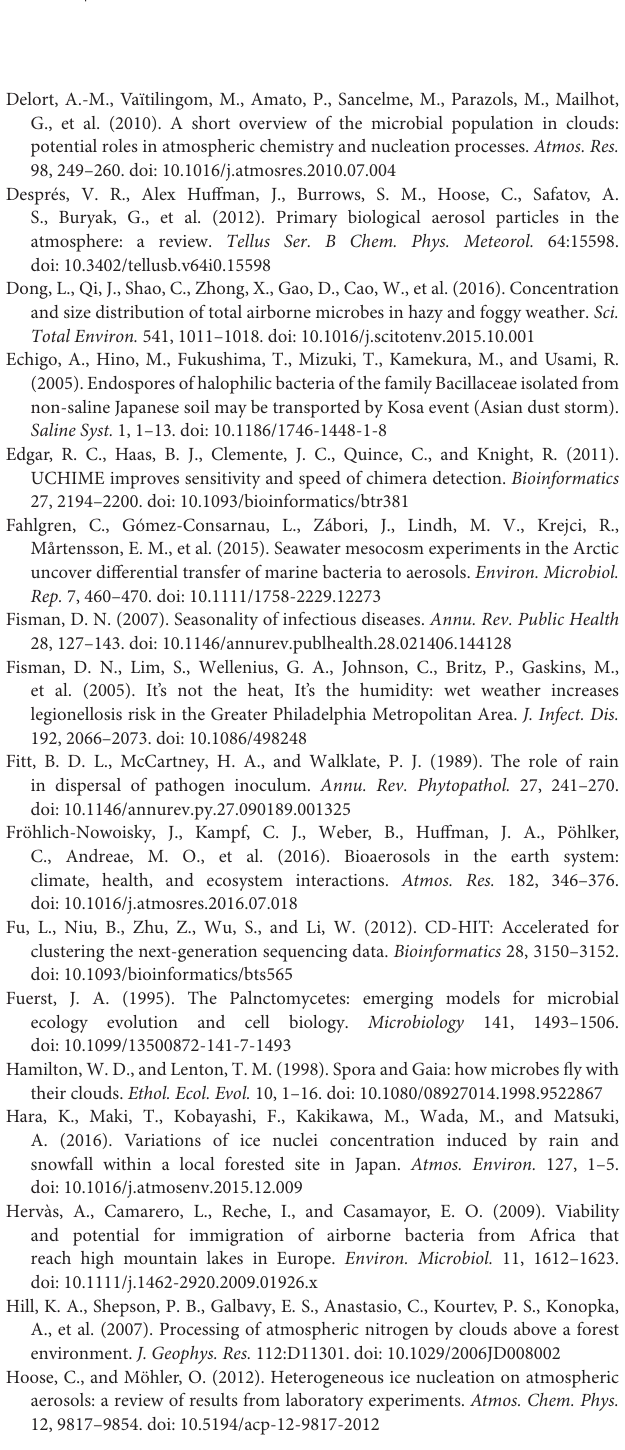
Supplementary Figure S3 | The estimated air mass backward trajectories 240h prior to precipitation events. Supplementary Figure S4 | Estimated ordinary habitats of precipitation microbes for three ecosystem groups. The abundance values in each ecosystem group are summation for habitats described below. Marine-related: “aquatic”, “marine”, “marine sediment”, “fish”, and “hot spring”; Animal-associated: “human”, “human gut”, “human lung”, “human nasal pharyngeal”, “bovine gut”, and “mouse gut”; and Soil-related: “hydrocarbon”, “rhizosphere”, “soil”, and